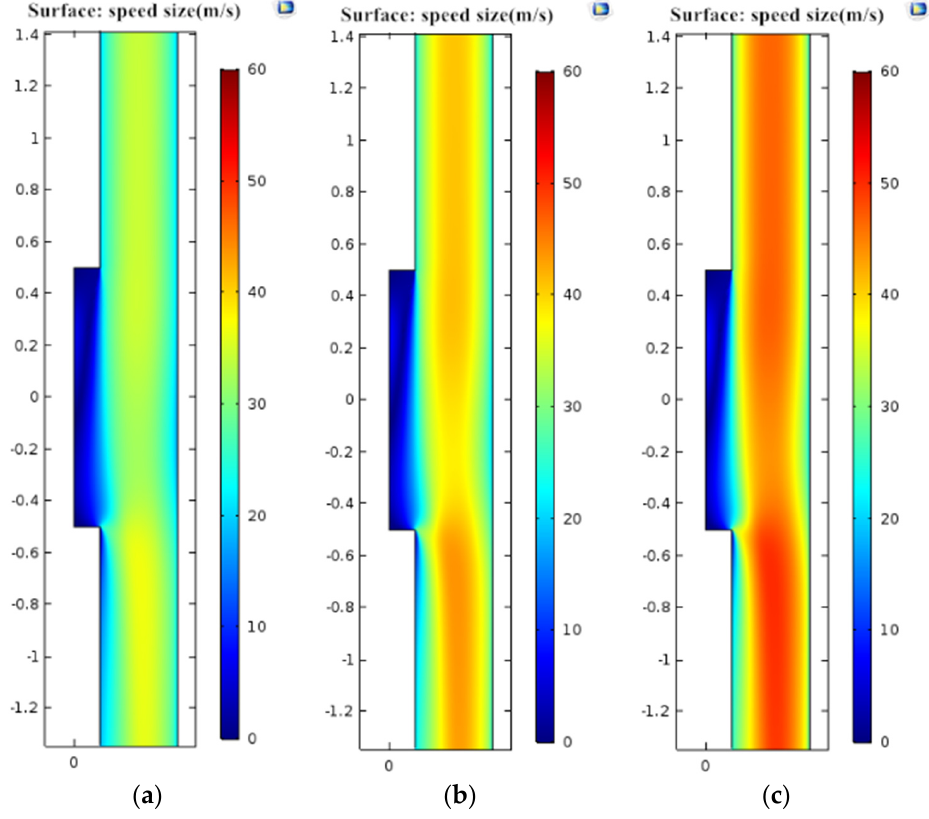
Figure 5. Velocity between poles under different inlet pressures. ( a ) 0.20 Mpa; ( b ) 0.23 Mpa; ( c ) 0.25 Mpa.